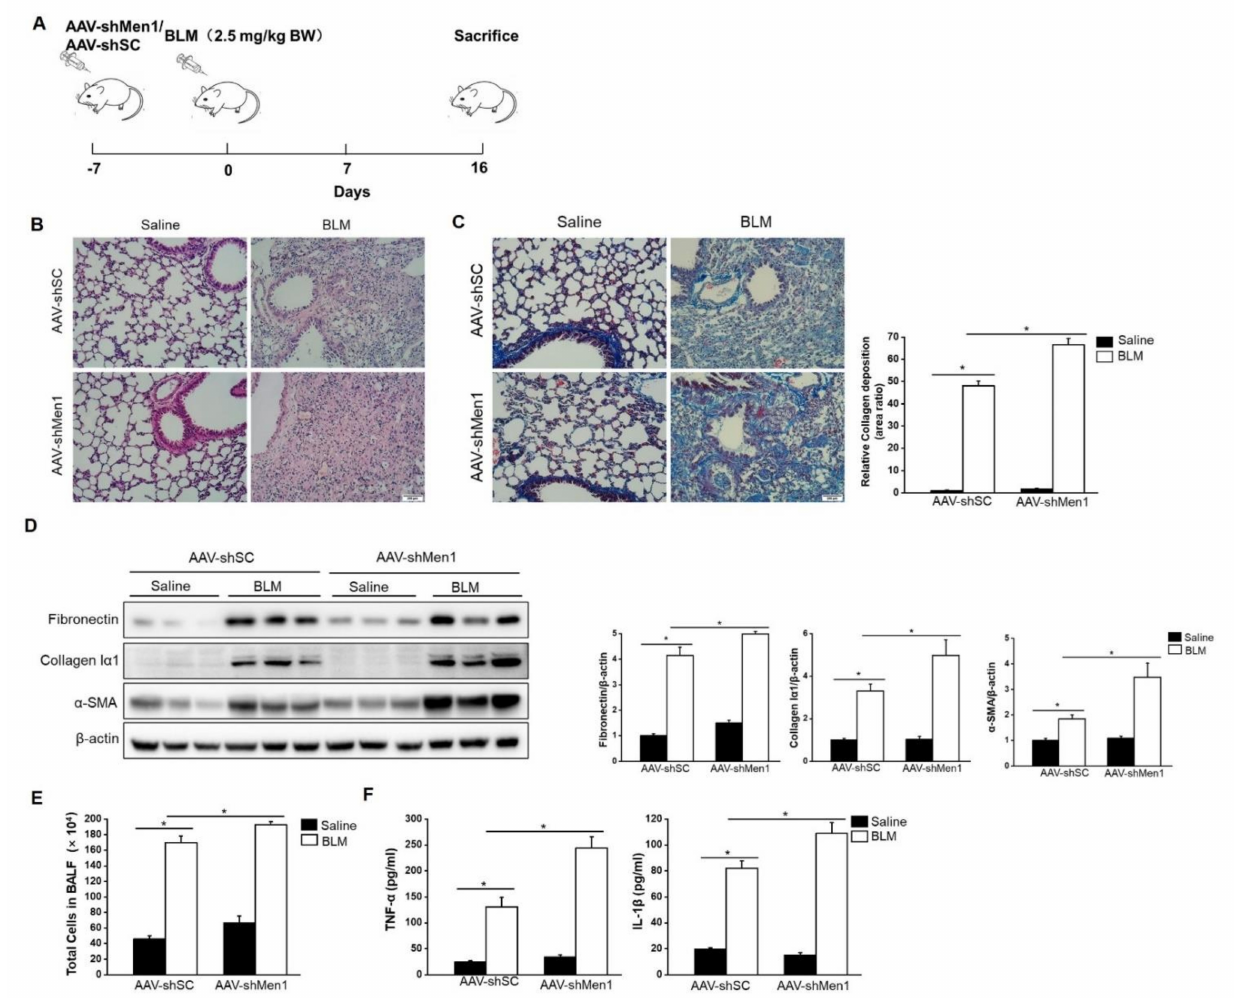
Figure 3. BLM—induced pulmonary fibrosis was worsened by Men1 knockdown. ( A ) Timeline for AAV infection and BLM stimulation in mice. ( B ) Morphology of lung tissue was examined by H&E staining. Scale bar: 200 µ m. ( C ) Masson staining of lung tissue. Collagen deposition was quantified by Image J software. Scale bar: 200 µ m. ( D ) Western blotting was used to estimate the protein levels of fibronectin, collagen I α 1, and α -SMA in lung tissue. Data were quantified by Image J software. ( E ) The total number of cells was counted in BALF. ( F ) The contents of TNF- α and IL-1 β were estimated by ELISA. n = 5 for each group. * p <